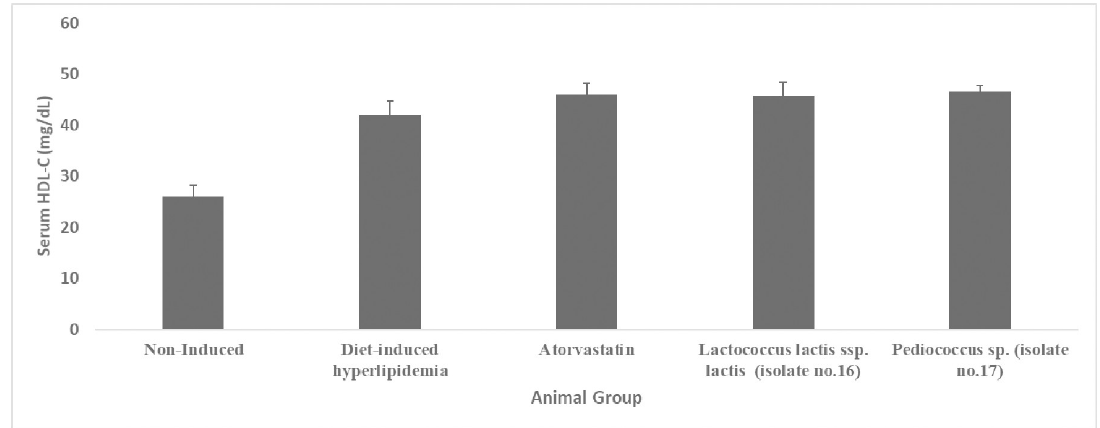
Fig 5. Serum HDL-C level (mg/dL) of hyperlipidemic hamsters. Non-induced group (standard food diet), diet-induced hyperlipidemic group (HFD-fed), Lactococcus lactis ssp. lactis group (HFD-fed + 1 × 10 9 CFU/mL /day), Pediococcus sp. group (HFD-fed + 1 × 10 9 CFU/ mL /day) and atorvastatin group (HFD-fed + 1.23 mg/kg/day atorvastatin). Data are represented as the mean ± SEM (n = 6). Asterisks indicate a significant difference ( p < 0.05).